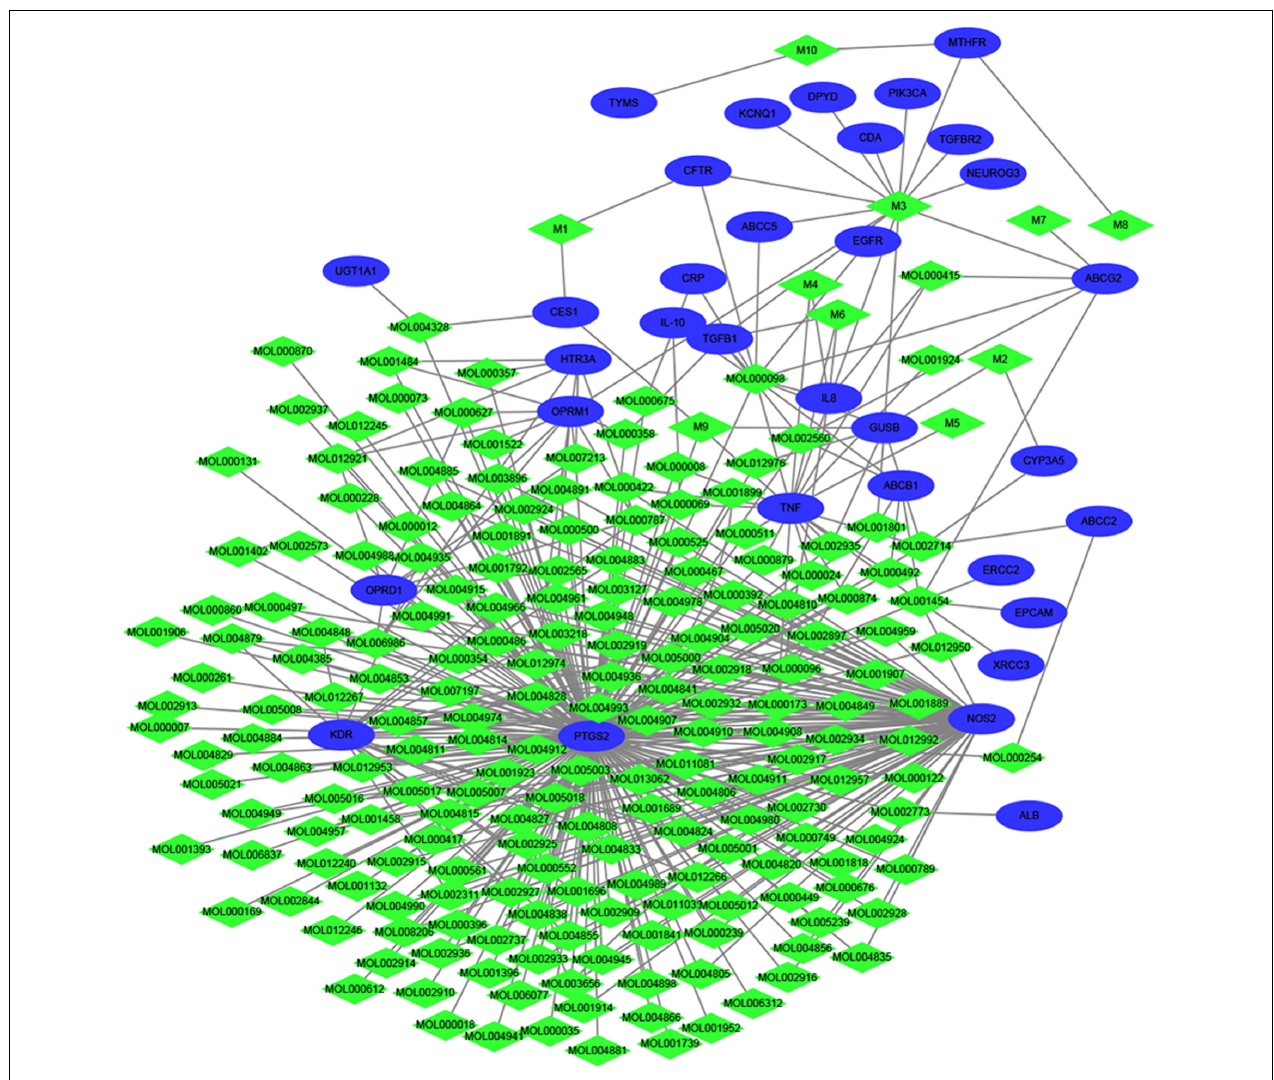
FIGURE 2 | Therapeutic compound-target network. The green diamond nodes represent compounds, and blue ellipses are